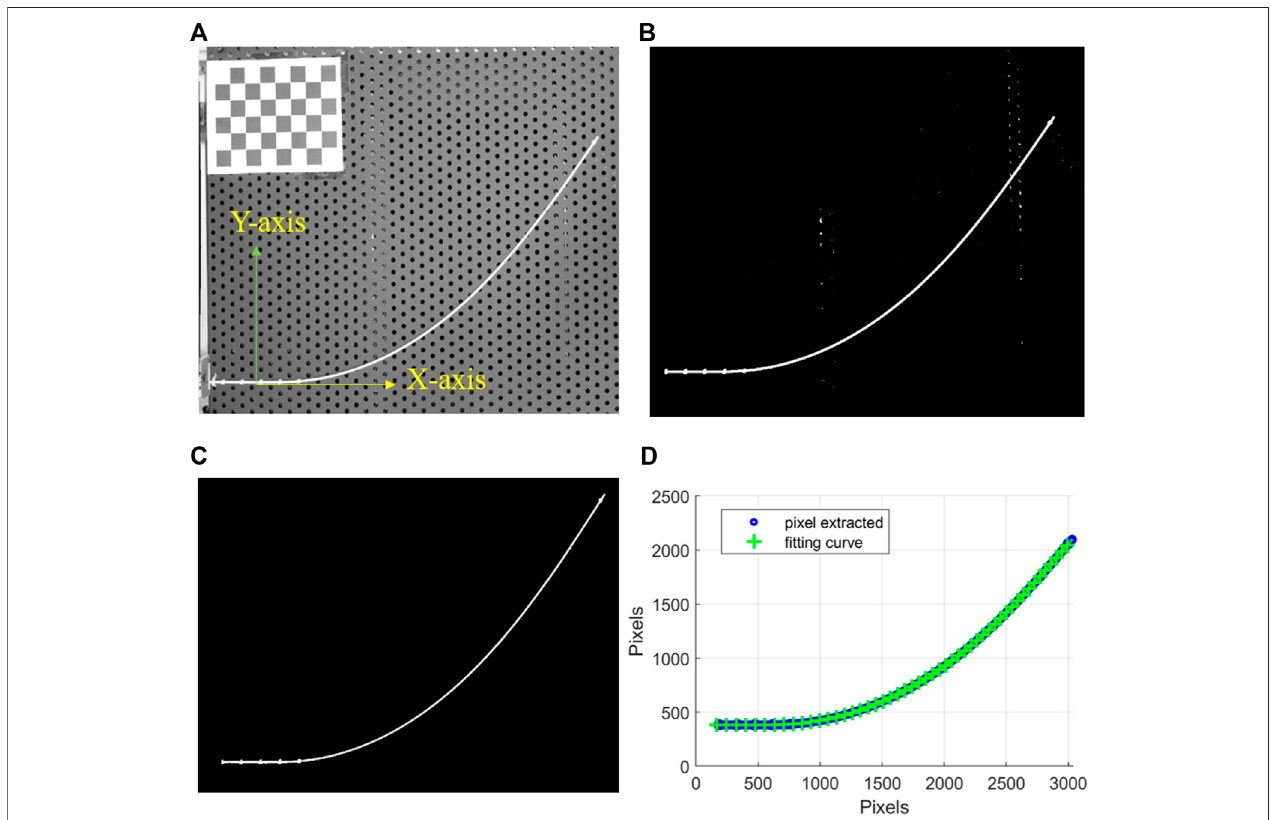
TABLE 1 | The channel shapes with different features. No. Starting location